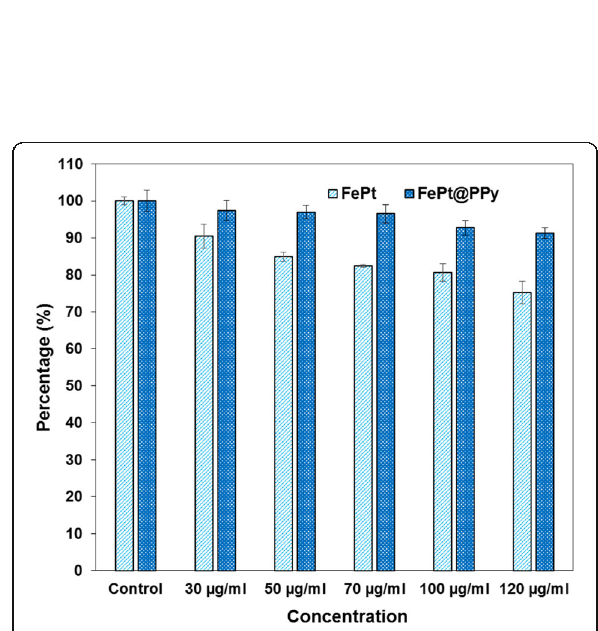
Fig. 7 Cell viability (with MTT assay) of MDA-MB-231 cells incubated with FePt and FePt@PPy NPs with different concentrations for 48